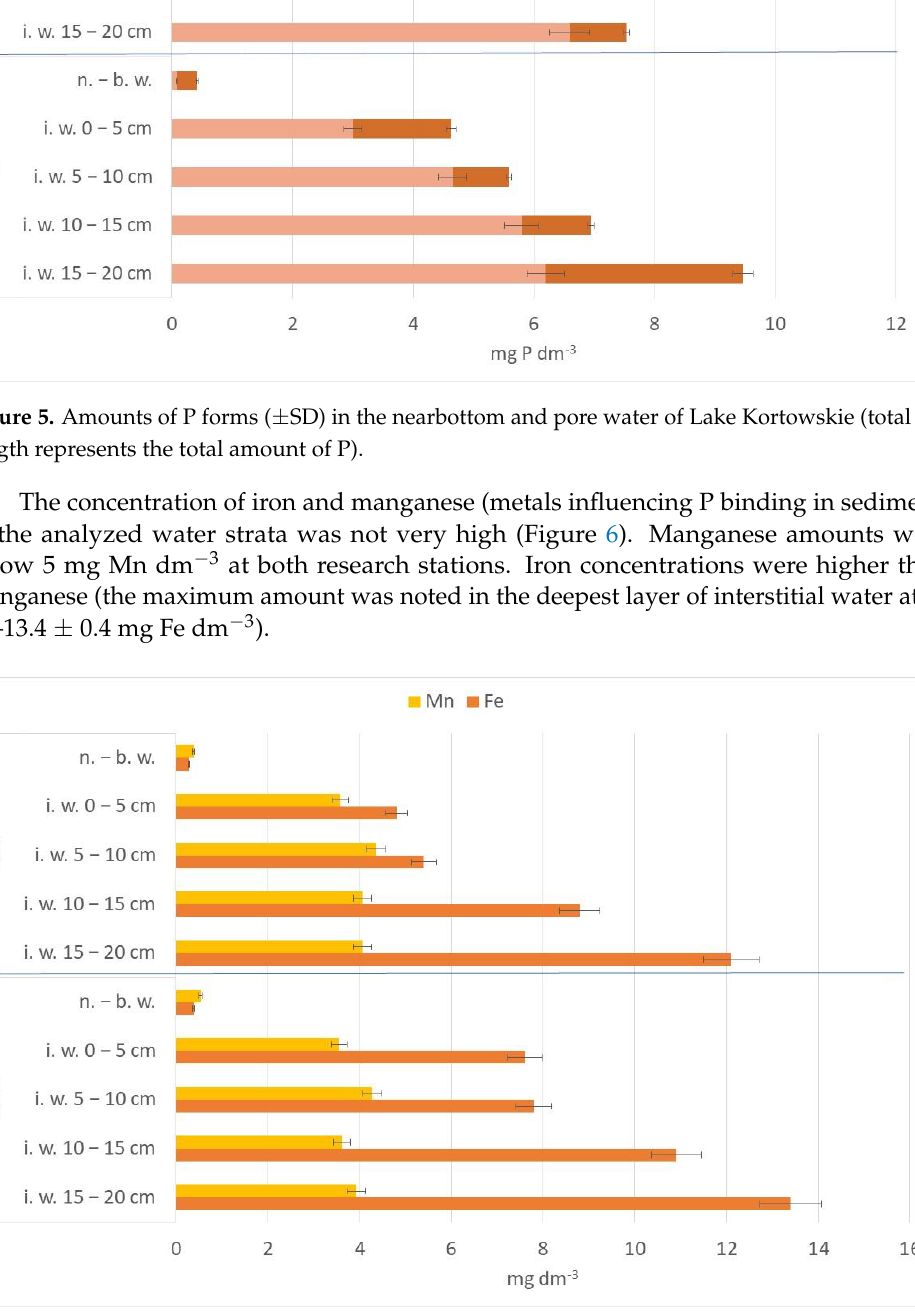
Figure 7. Amount of components in bottom deposits (±SD) of Lake Kortowskie (in %DW). The analyzed sediment of Lake Kortowskie was not abundant in phosphorus. The TP amounts ranged between 1.771 mg P g −1 DW (St. 2, sediment layer 10 – 15 cm) and 2.593 mg P g −1 DW. Performed analysis of sediment phosphorus fractions in Lake Kortowskie revealed that the main P fractions in analyzed lake sediment were hardly bioavailable fractions: res-P (residual phosphorus, permanently bound to sediment) and HCl-P (P bound to Ca), which had the highest share of TP (up to 72%TP for res-P at. St. 1 and up to 57%TP for HCl-P at St. 2). Moderately bioavailable fraction NaOH-nrP (P bound to OM) occupied up to 26%TP at St. 1. The rest of fractions occurred in low amounts. One excep- tion was the deepest sediment layer from St. 1. This sediment was abundant in NaOH-rP (P bound to aluminum and iron oxides and hydroxides) and BD-P (redox-sensitive P)